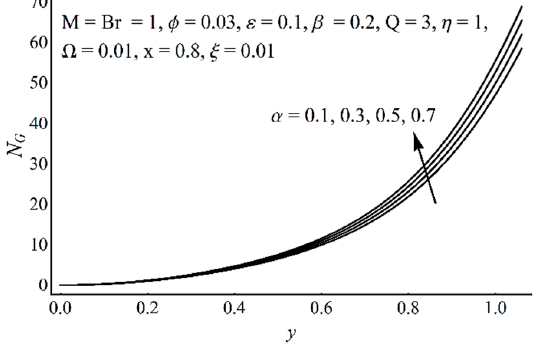
Figure 20. The total entropy generation number against various α values.